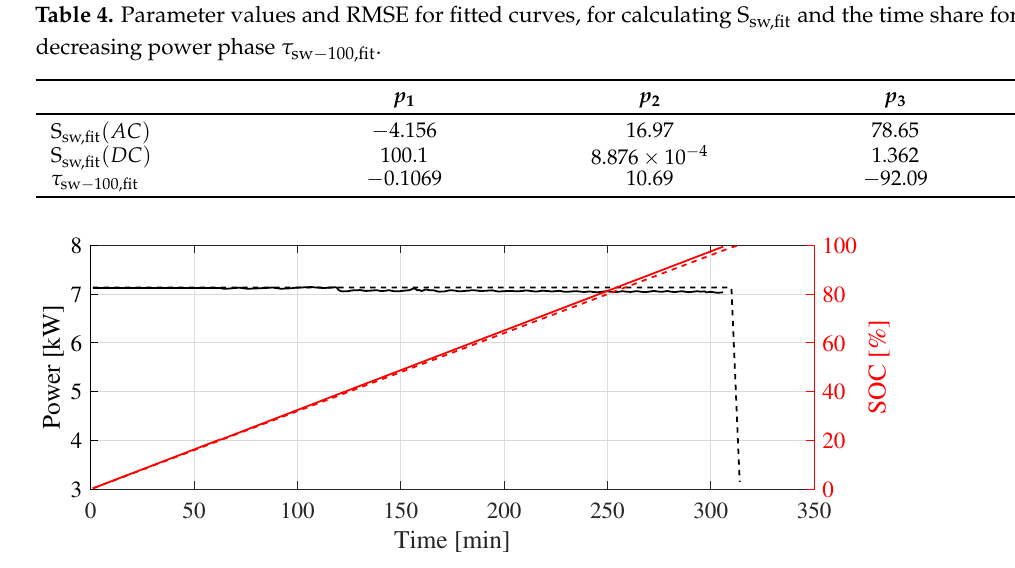
Figure 9. VW e-Golf measured charging profile from SOC = 37% and extrapolated to SOC = 0% in straight lines with data from [38] and the pre-calculated charging profile based on the state of charge switching-point model in dashed